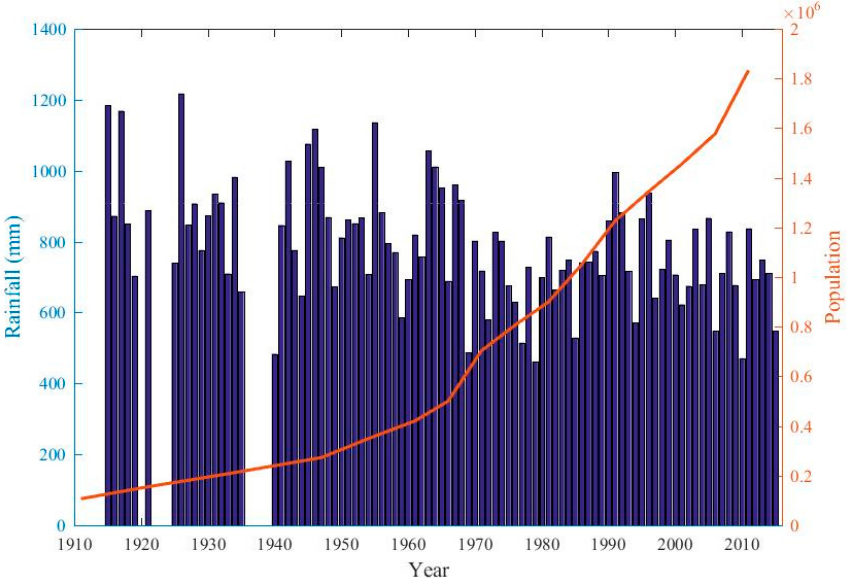
Figure 3. Population growth in Perth between 1910 and 2015 [50] shown against the annual rainfall data over the same period, where available [51]. The decreasing annual rainfall results in reduced water availability.